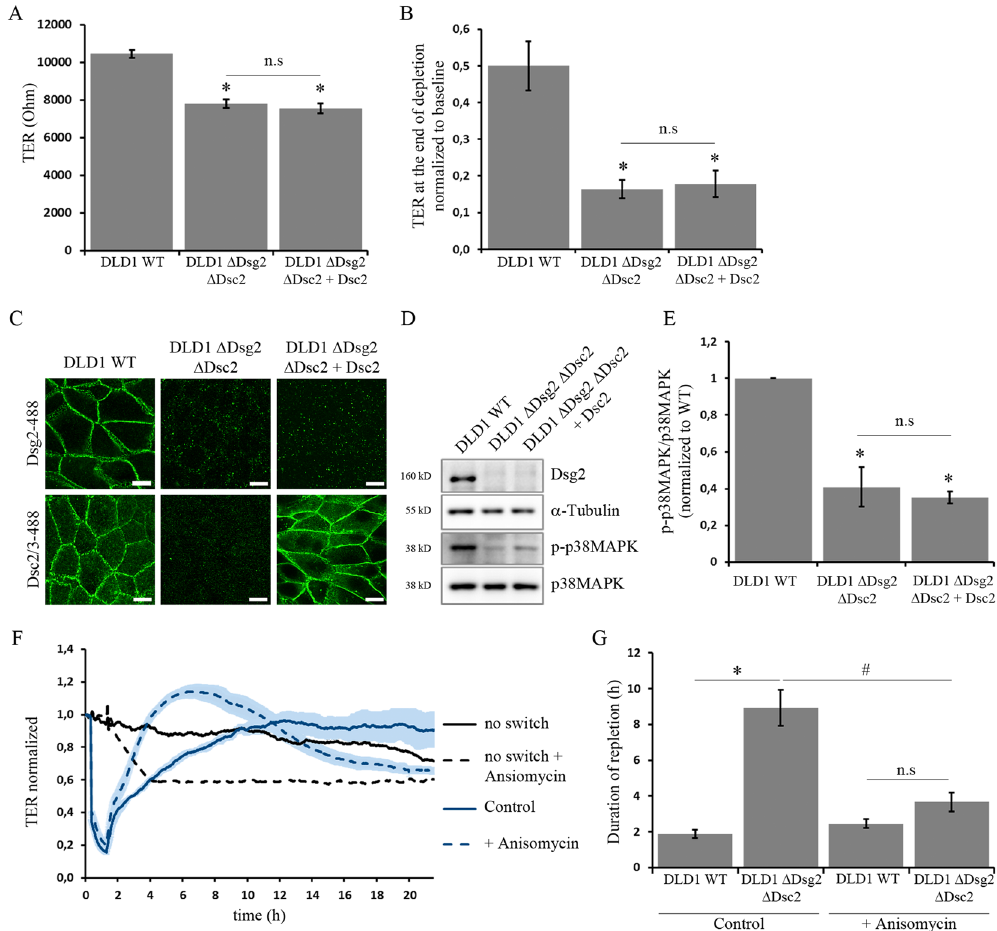
Figure 5. Dsg2 regulates p38MAPK activity which is required for barrier properties. ( A ) Comparison of baseline TER values between wildtype and knockout cells revealed reduced TER in DLD1 cells lacking Dsg2 (shown is mean ± SE, n ≥ 10, * p < 0,05 compared to control, n.s not significant). ( B ) During Ca 2 + depletion for 1 h TER values of Dsg2-deficient cells decreased stronger compared to wildtype cells. (Shown is mean ± SE, n ≥ 6, * p < 0,05 compared to control, n.s not significant). ( C ) Wildtype and knockout cells grown on coverslips were stained for Dsg2 and Dsc2 to confirm knockout. Scale bar, 10 µ m ( D ). Level of p-p38MAPK in Dsg2 and Dsc2 knockout cells was analysed via Western blot. Loss of Dsg2 and Dsc2 resulted in reduced level of p-p38MAPK which was not restored by Dsc2 rescue. α -Tubulin served as loading control. Cropped blots are displayed and full-length blots are included in the supplementary information. ( E ) Band intensity of detected p-p38MAPK was quantified using ImageJ and normalized to control (shown is mean ± SE, n ≥ 3, * p < 0,05 compared to control, n.s not significant). ( F ) Time for complete repletion during Ca 2 + -switch experiments was compared between wildtype and double knockout of Dsg2 and Dsc2. Loss of desmosomal cadherins resulted in a prolonged repletion time which was rescued by activation of p38MAPK via anisomycin (shown is mean ± SE, n ≥ 6, * p < 0,05 compared to wildtype under control conditions, #p < 0,05 compared to Δ Dsg2 Δ Dsc2 under control conditions, n.s not significant). ( G ) Treatment with anisomycin reduced repletion time in Δ Dsg2 Δ Dsc2 knockout cells. Representative graph for at least four independent Ca 2 + -switch experiments is